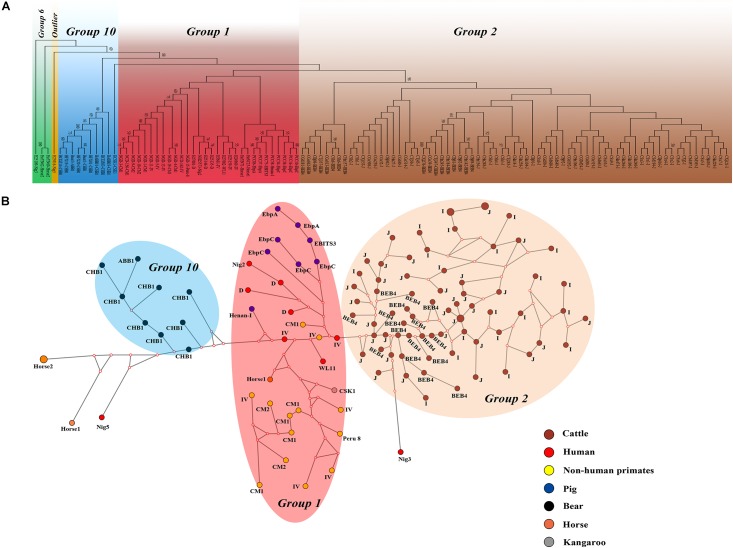
Phylogenetic and haplotype network of E. bieneusi isolates from different hosts and geographic origins. All dairy cattle E. bieneusi isolates (n = 71) identified in this study were included in the analyses and some of the Group 1 isolates (n = 30) with genotypes being D, EbpC, type IV, horse1, Nig2, EBITS3, Henan-1, WL11, CM1, and CM2, Group 6 isolates (n = 3) with genotypes being horse2 and Nig3, Group 10 isolates (n = 10) with genotypes being CHB1, CSK1, and ABB1, and an outlier isolate genotype Nig5 were selected for comparative analysis. (A) NJ phylogenetic analysis of all E. bieneusi isolates by the Kimura 2-parameter model, implemented in MEGA version 7.01. The letters B, H, Ho, P, C, N, and K, indicate the isolates were sampled from bear, human, horse, pig, cattle, non-human primates, and kangaroo, respectively. Bootstrap values of N > 50% from 1,000 replicates are displayed. (B) Median-joining analysis of the MLST data from all E. bieneusi specimens using the Network program. Circles are proportional to the frequency of each genotype and node sizes are proportional to the total haplotype frequencies. The colors within the circles represent the different ITS genotypes.